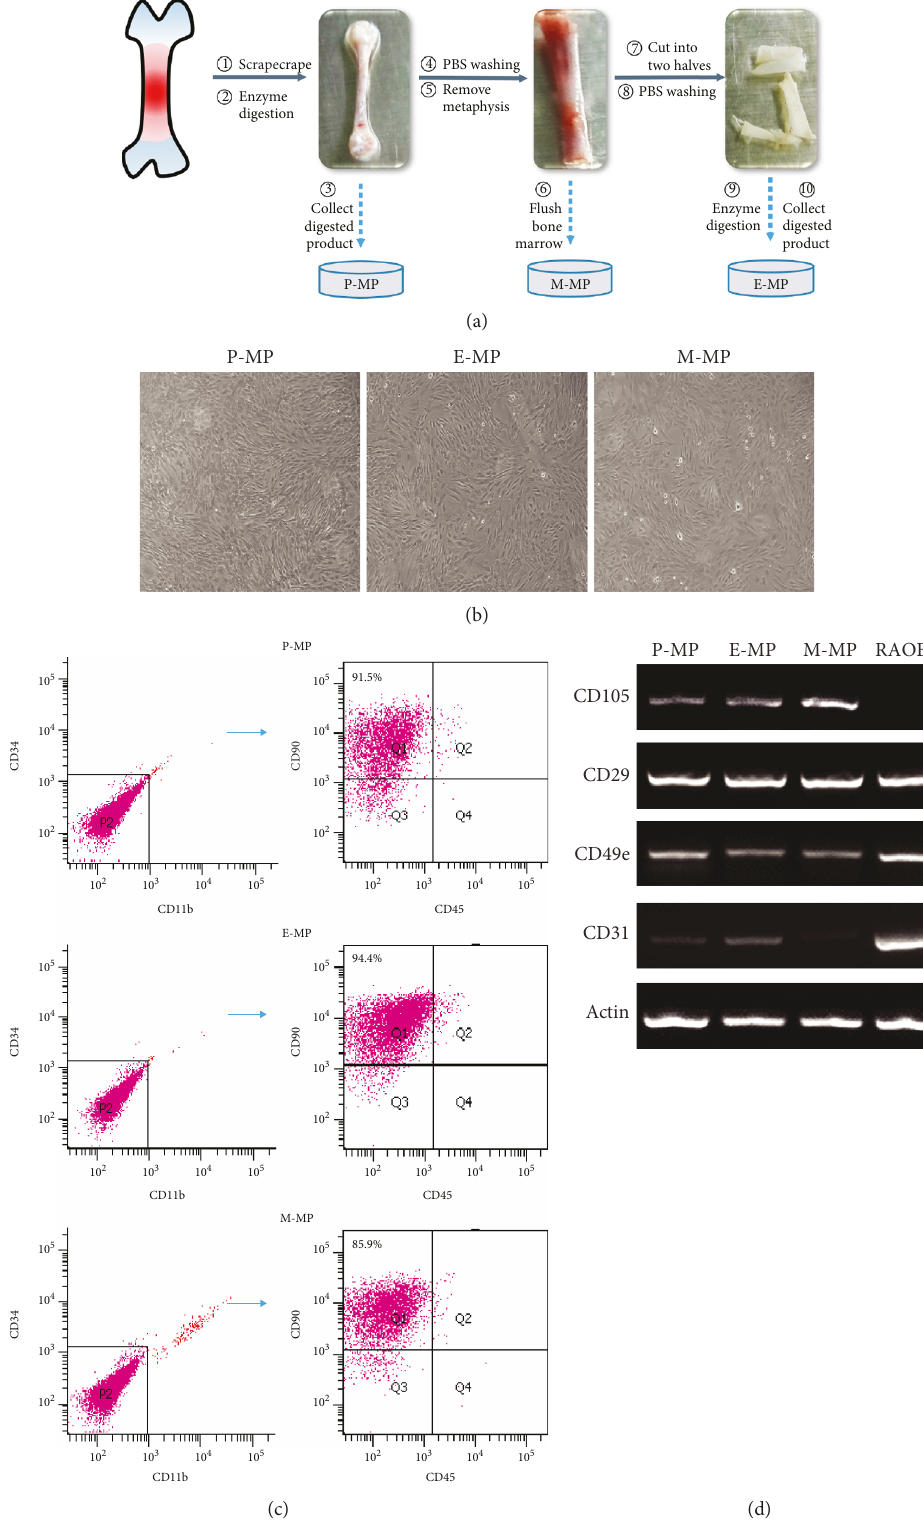
Figure 1: Mesenchymal progenitors were isolated and identi fi ed. (a) The schematic diagram of isolating MPs from di ff erent regions of rat long bones. Detailed procedures were described in Materials and Methods. (b) P-MPs, E-MPs, and M-MPs showed similar morphologies. Scale bar, 200 μ m. (c) Flow cytometric analysis was used to detect the presence of common MP-associated cell surface antigens, and the proportions of CD90+CD34-CD45-CD11b- cells were evaluated. (d) Semiquantitative PCR and agarose gel electrophoresis analysis were used to detect the expression of other stem cell surface markers, and CD31 was a marker of endothelial